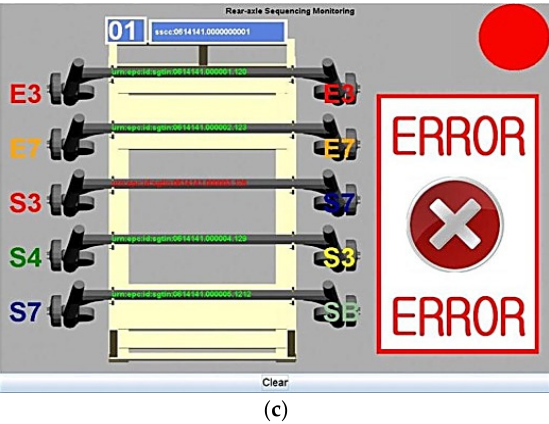
Figure 9. The sequencing process at the consolidation center. ( a ) Read point at sequencing area; ( b ) Screen shot of sequencing application in the case of no ‐ error; ( c ) Screen shot of sequencing application in the case of sequencing ‐ error.